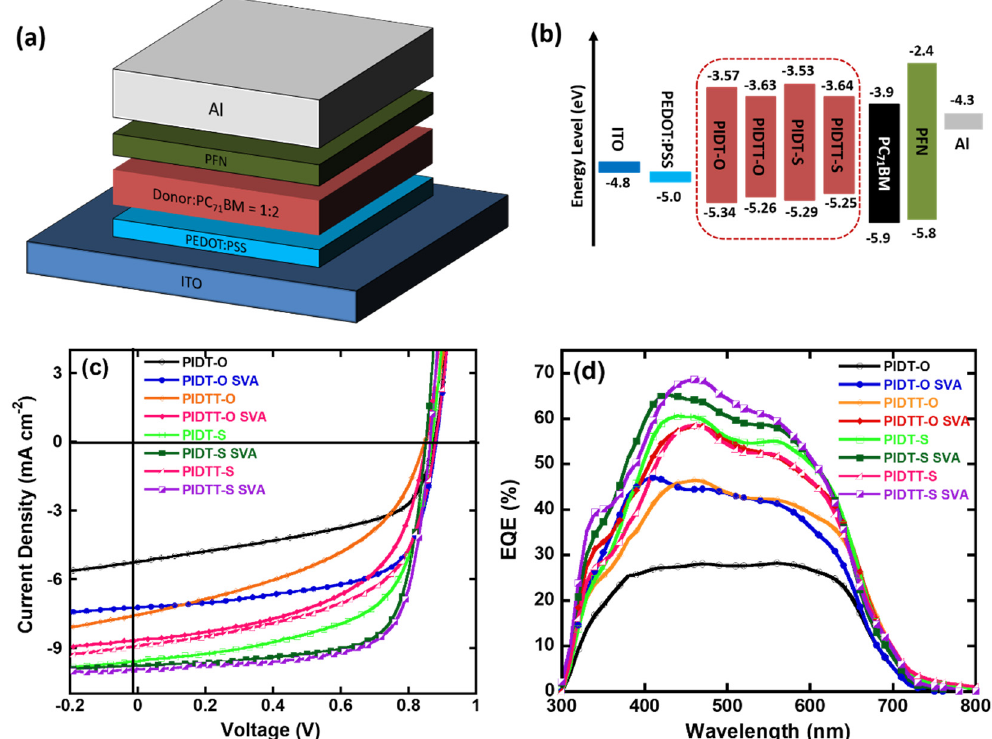
Figure 4. ( a ) The architecture of BHJ devices. ( b ) Energy level diagram of the photovoltaic materials. ( c ) J-V curves; and ( d ) the external quantum efficiency spectra of the BHJ photoactive OSCs.